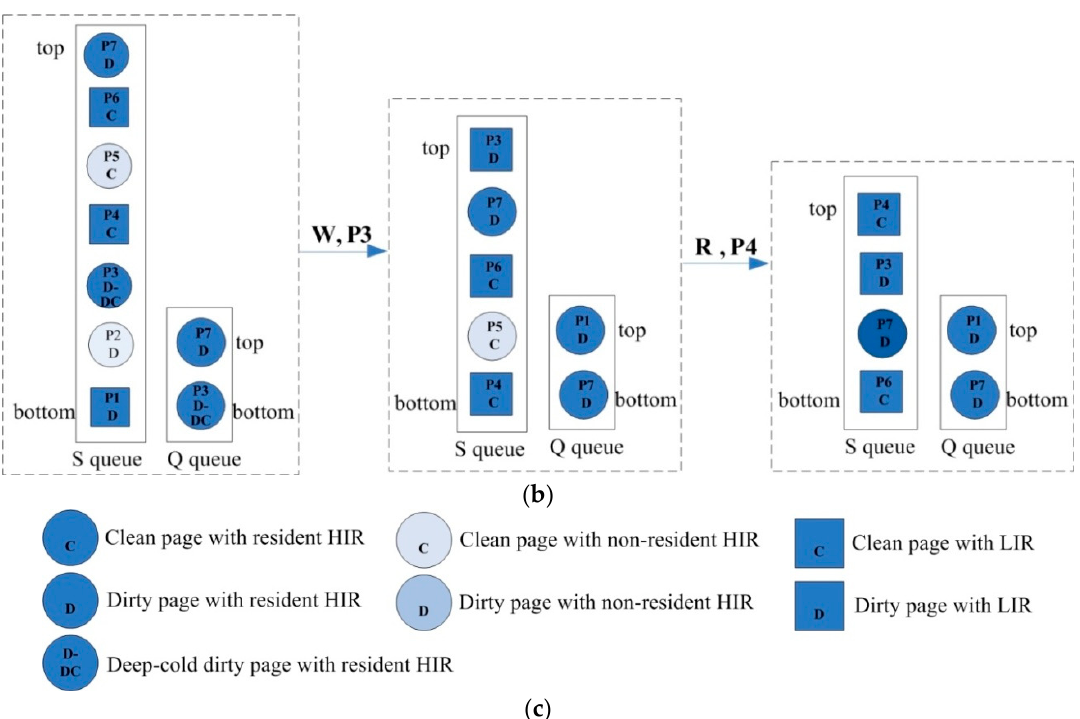
Figure 3. Examples of the insertion policy, promotion policy and victim selection policy for probability-based LIRS (P-LIRS). ( a ) Upon accessing page 7, which is not in the S queue, page 5 is driven out, and page 3 is set with a deep-cold-flag; ( b ) upon accessing high IRR (HIR) page 3, which is in the S queue, the page’s status is changed to low IRR (LIR), and a stack pruning is conducted. Upon accessing LIR page 4, which is in the S queue, the page is inserted at the top of the S queue, and a stack pruning is conducted. ( c ) Description of the pages that appear in ( a ) and ( b ).